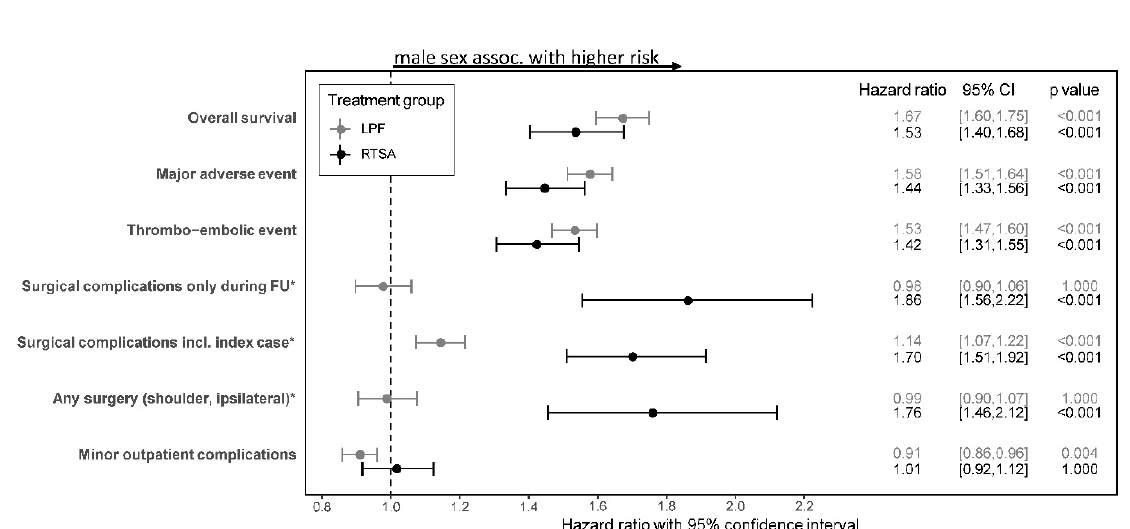
Figure 3. Association of sex with different target events during follow-up depending on treatment group determined by multivariable Cox regression models including sex, treatment group, interaction between sex and treatment group (sex * treatment group), age and patient’s risk profile at index surgery. p values were adjusted using Bonferroni–Holm procedures. For all studied events, the time from discharge of the index case to the target event was fitted. For any surgical complications, any surgery during follow-up, secondary ipsilateral surgery on the shoulder and minor outpatient complications, death was considered a competing risk and sub-distribution hazard ratios were estimated. Sub-distributional hazard ratios comparing male and female sex for the interaction of sex and treatment group, 95% CIs and adjusted p values are presented. Results of all regression models are collected in Supplementary Materials, Table S3. * significant differences of HR (comparing male vs. female sex) between treatment groups. CI—confidence interval, locked plate fixation—LPF, reverse total shoulder